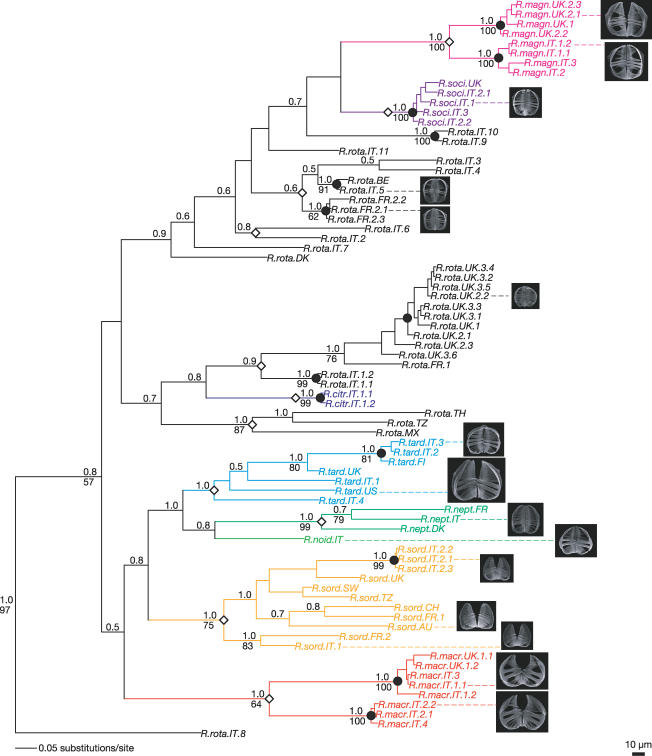
Phylogenetic Relationships in the Genus Rotaria
The consensus of 80,000 sampled trees from Bayesian analysis of the combined cox1 and 28S rDNA data sets is shown, displaying all compatible groupings and with average branch lengths proportional to numbers of substitutions per site under a separate GTR + invgamma substitution model for the cox1 and 28S partitions. Posterior probabilities above 0.5 and bootstrap support above 50% from a maximum parsimony bootstrap analysis are shown above and below each branch, respectively. Support values for within-species relationships are not shown for very short branches but are shown in Figures S1 through S3. Closed circles indicate clusters identified by the clustering analysis. Colors represent traditional species memberships. Diamonds indicate taxonomic species and monophyletic groups of Rotaria. Names refer to the species, the country, the number of site within that country for that species, and the number of individual from that site if several were isolated; for example, R.macr.IT.1.1 refers to the first individual from site 1 in Italy for R. macrura. Pictures of trophi from one individual from each cluster are shown to scale: Representatives of all sampled populations are shown in Figure S4. A full list of names and localities of samples is available in Table S1.